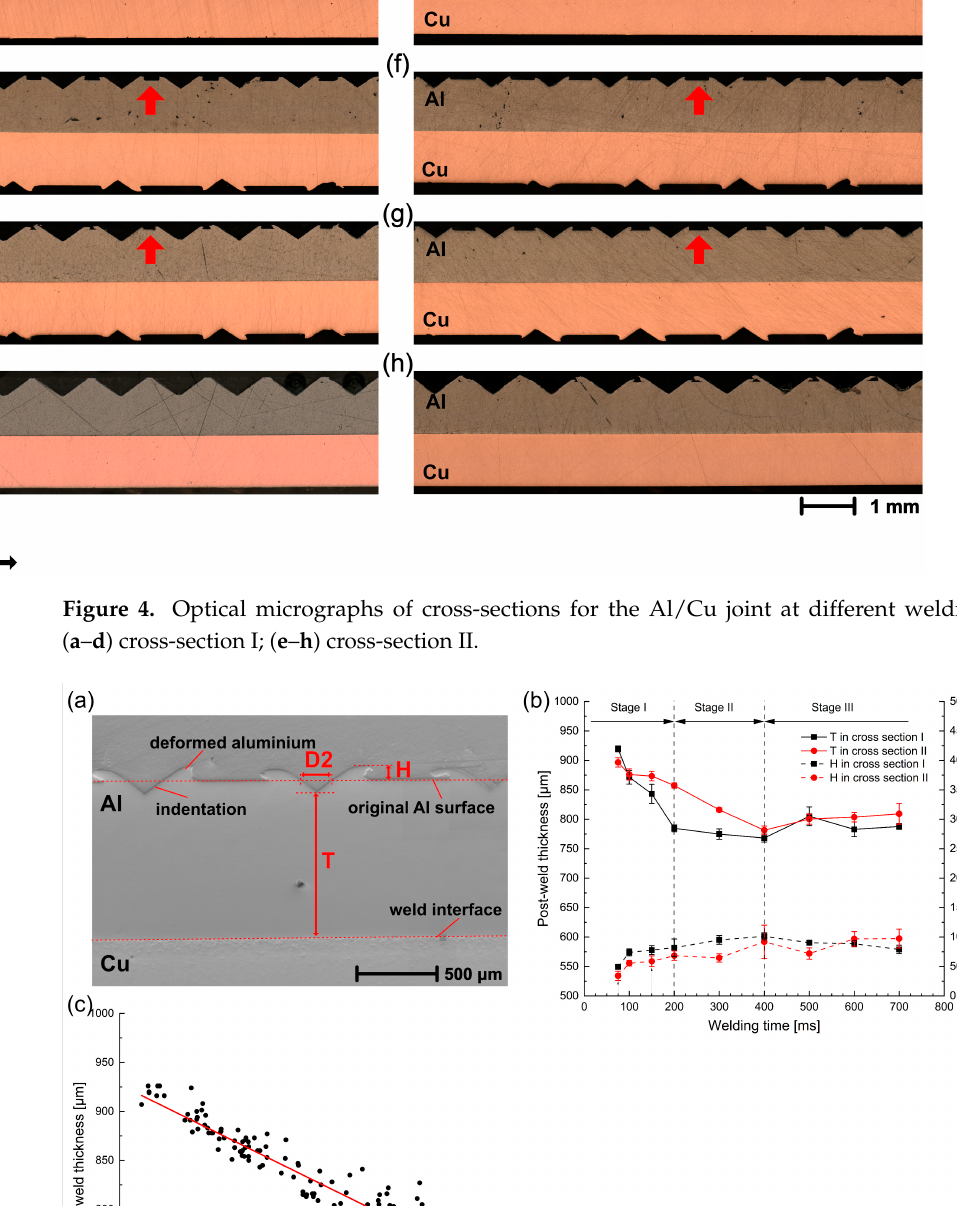
Figure 5. ( a ) Definition of postweld thickness T and height of deformed Al H, ( b ) variation in post- weld thickness T and height of deformed Al H with welding time, and ( c ) postweld thickness T vs. width for indentation